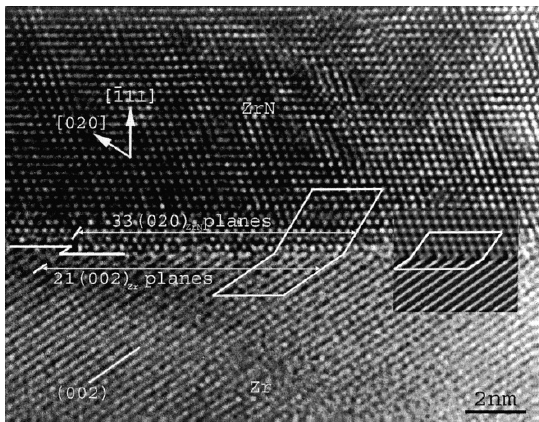
Figure 11. HREM image of an incoherent Zr-ZrN interface in a Zr-N alloy. (Reprinted from Reference [87], with permission from